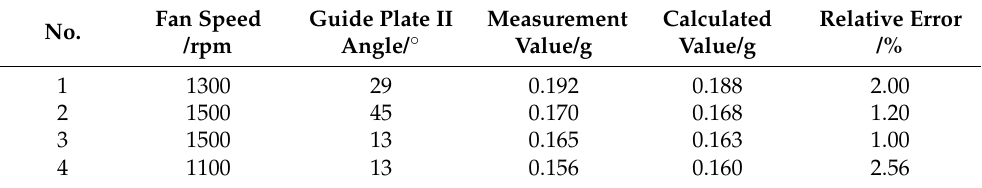
Table 7. Relative error between theoretical and practical values for Equation (3).